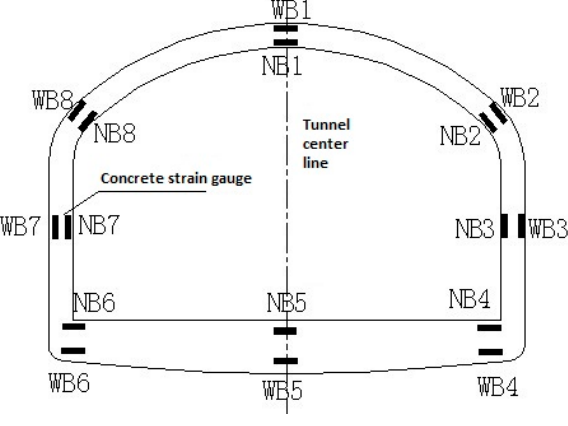
Figure 7. Layout of measuring points for each monitoring section.